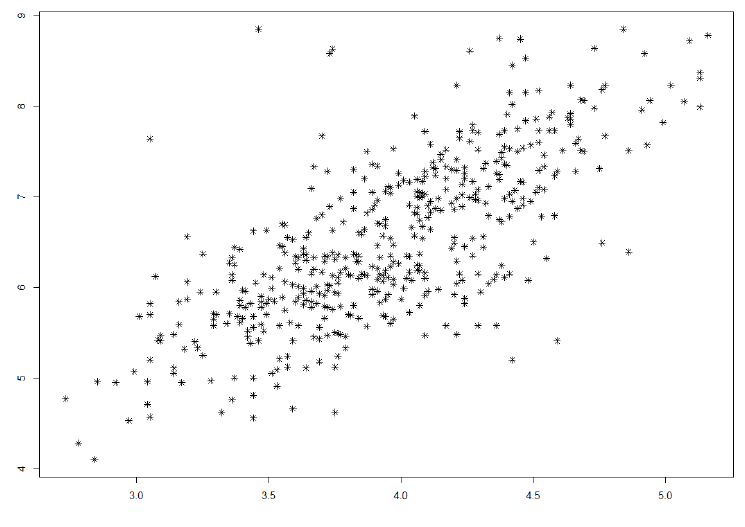
Figure 9: scatter plot of the data